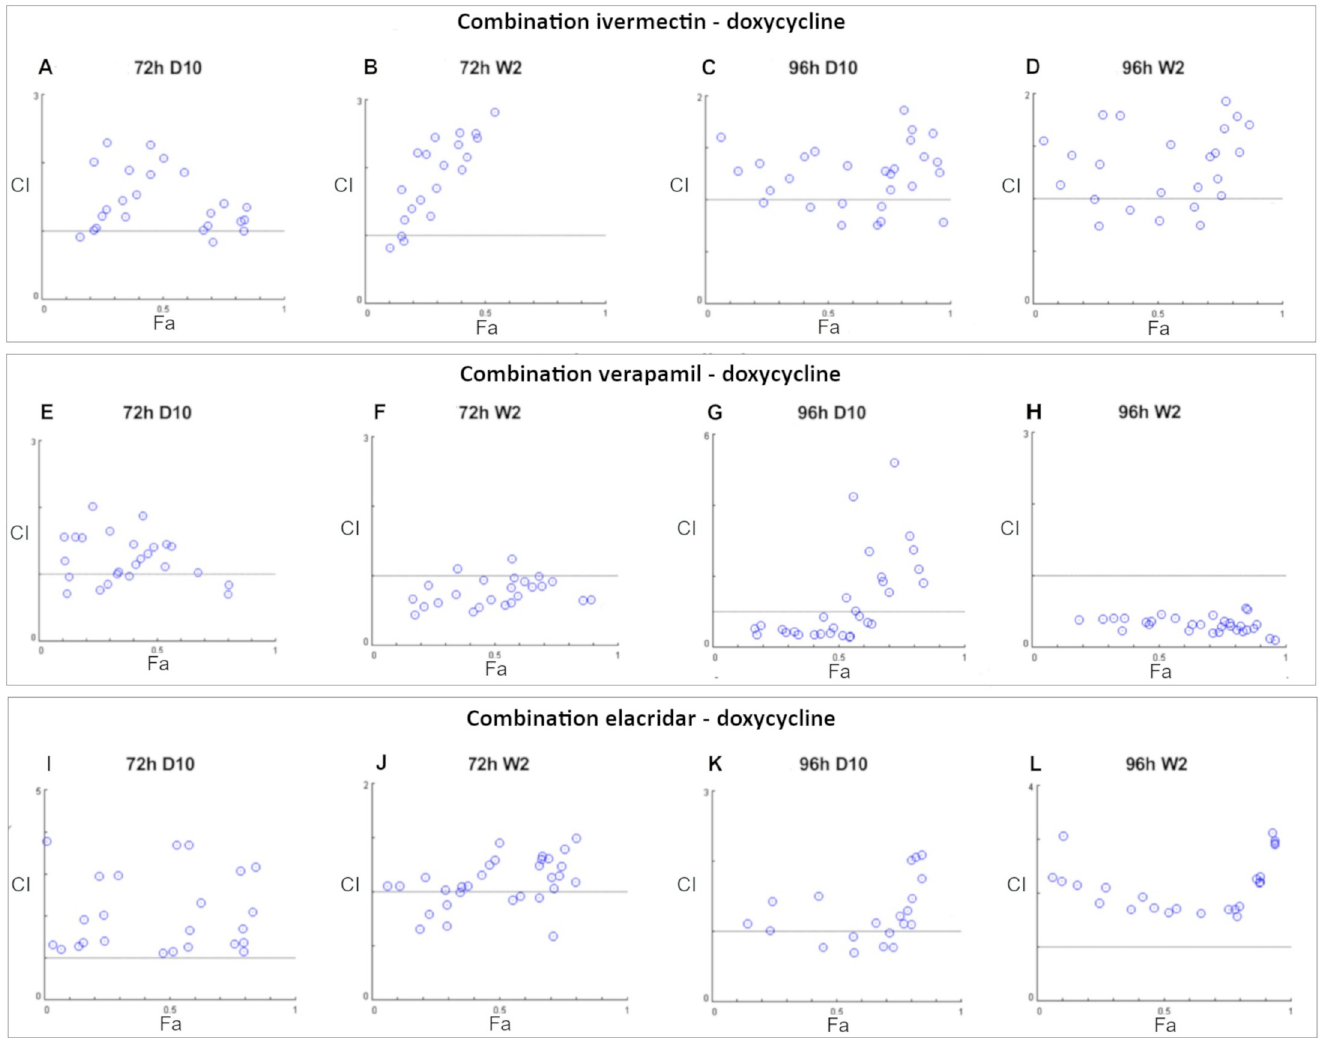
Fig 2. Combination index plots for the anti- P . falciparum activity of ivermectin (Ivm), verapamil (Vpl) or elacridar (Elc) in combination with doxycycline (Dox) against P . falciparum . The data are representative of three independent experiments in duplicate for each combination. The 72h assays were performed on asynchronous cultures of P . falciparum , while the 96h assays were performed on synchronous cultures of the parasites with a medium change after 24h (see M&M for details). Combination of Ivm-Dox (from A to D); combination of Vpl-Dox (from E to H); combination of Elc-Dox (From I to L).